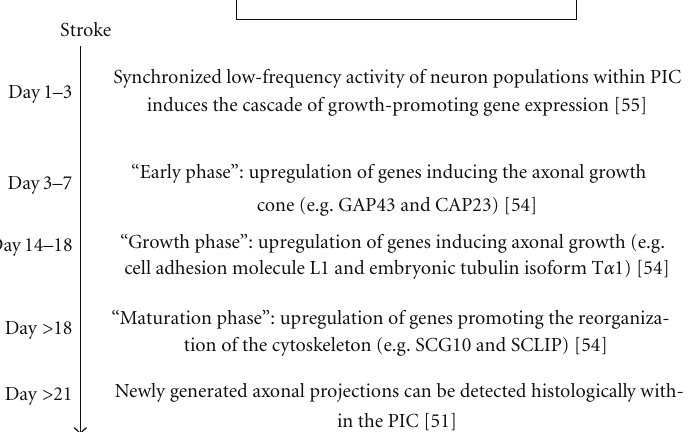
the first four weeks after a stroke was induced. Within this dynamic remodeling phase, the network is especially sensi- tive to therapeutic interventions suggesting the occurrence of synergistic e ff ects on plasticity when training coincides with lesion-induced (spontaneous) reorganization